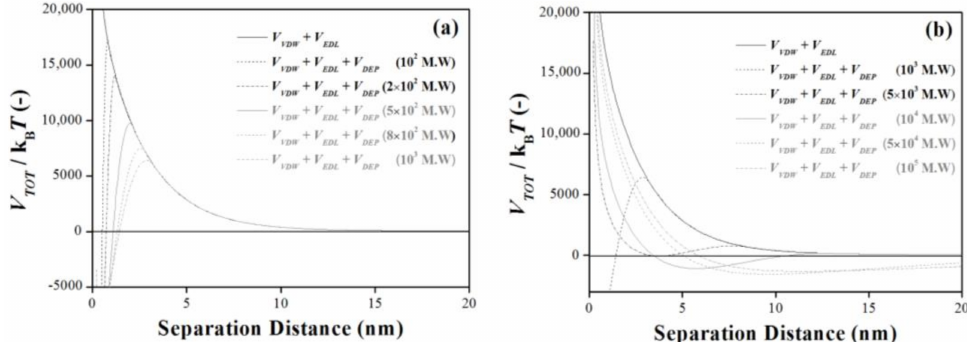
Figure 4. The interaction energy profiles for DLVO including the depletion interaction with varying the lower molecular weight of the depletant (10 2 –10 3 MW) ( a ) and higher molecular weight of the depletant (10 3 –10 5 MW) ( b ) are represented as a function of the separation distance, respectively. The values of the silica-bubble-water Hamaker constant ( − 3.12 × 10 − 21 J), ionic strength (20 mM), silica surface potential ( − 0.02 V at pH 7), bubble surface potential ( − 0.025 V at pH 7), polymer weight (10 wt %) and polymer volume fraction (8.84 × 10 − 1 ( v / v )) are